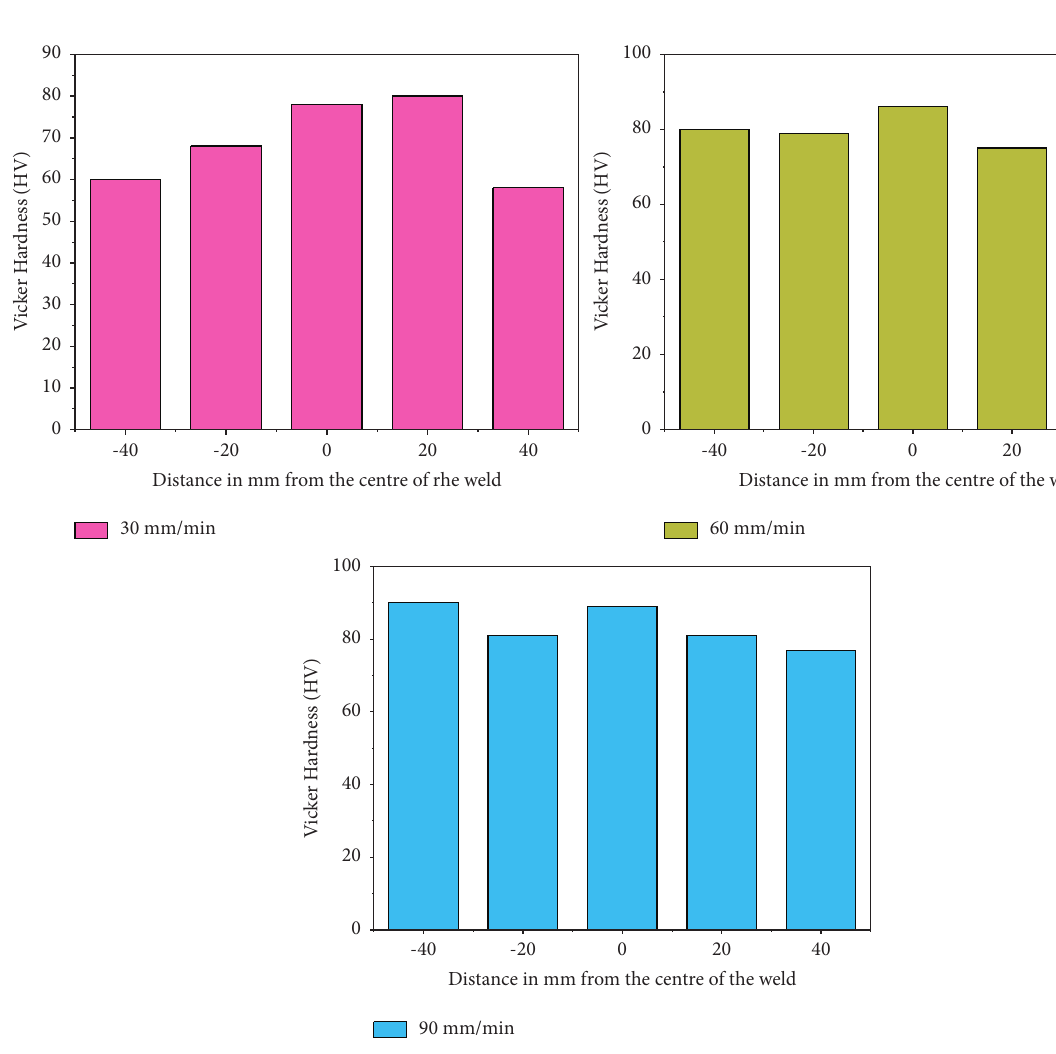
Figure 6: Vickers hardness value for the cylindrical